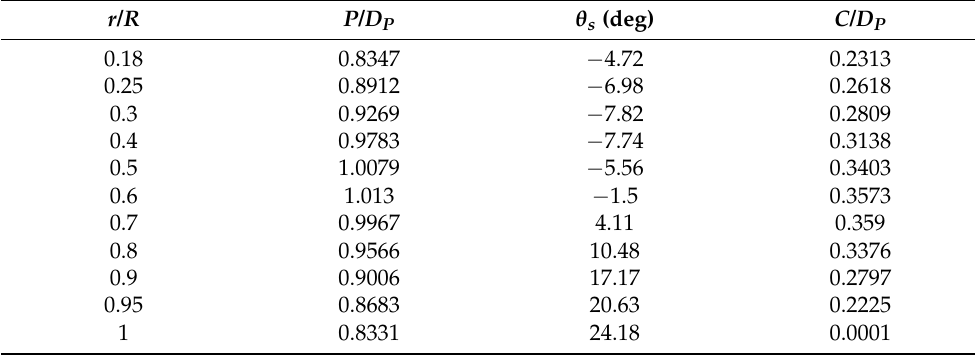
Figure 7. Technical drawing of KP505 propeller. Blue line is the mid-chord line made by Equations (3) and (4). Red and green lines are the leading and trailing edges, respectively, generated by Equations (5) and (6). Table 3. Offset table of KP505 propeller.